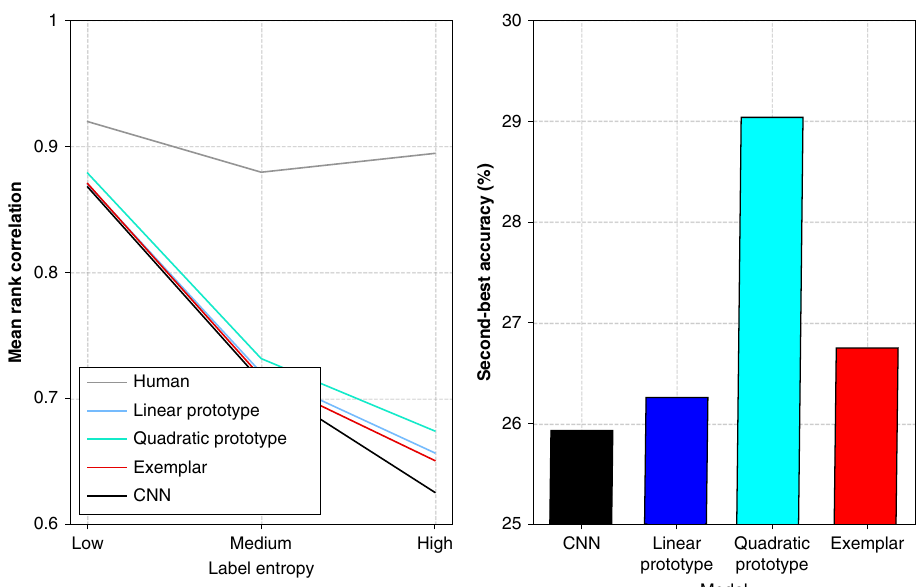
Fig. 6 Correlation results and second-best accuracy. Left: average Spearman ’ s rank correlation coef fi cient for images with low-, medium-, and high- entropy guess distributions. Right: second-best accuracy (SBA) for best-performing CNN baseline and categorization models. Source data are provided as a Source Data fi